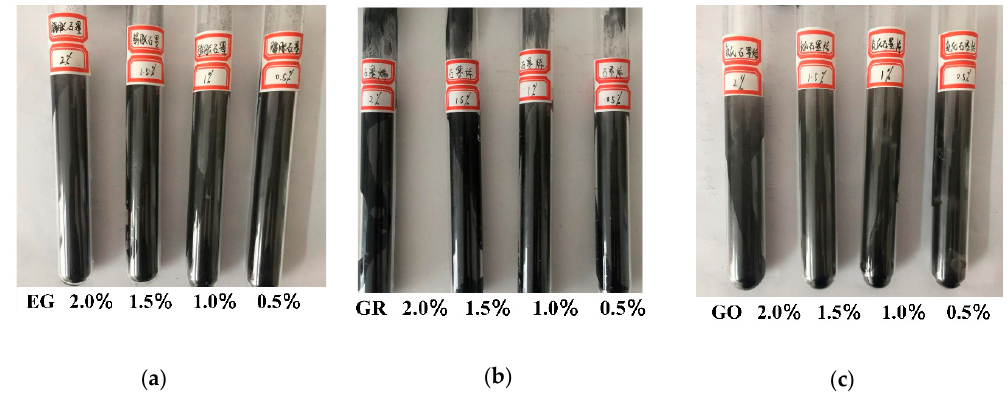
Figure 3. Photographs of CPCM with ( a ) EG, ( b ) GR, and ( c ) GO.